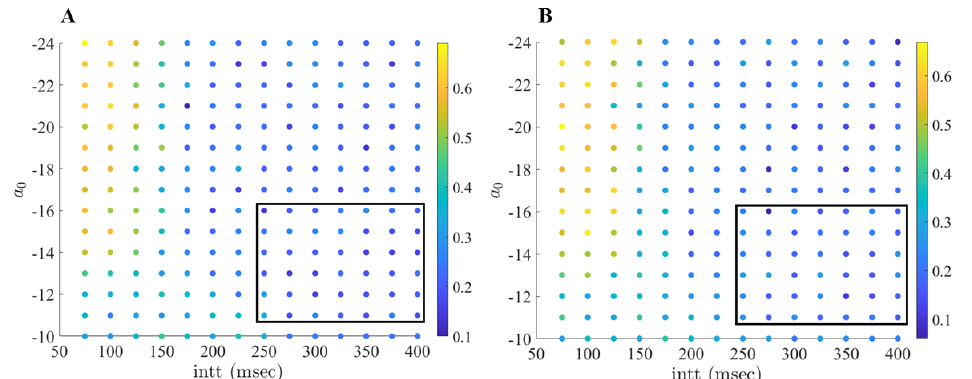
Figure 5. ( A ) Error index values (color coded) for the first TC cell, TC 1 over a range of interspike threshold parameter values intt (75–400 ms, with increment 25 ms) and a 0 —stimulation strength ( − 24 to − 10, with increments of 1). ( B ) Error index values for the second TC cell, TC 2 over a range of values intt (75 to 400 ms, increment 25 ms) and a 0 ( − 24 to − 10, with increment 1). The favorable region of ( intt , a 0 ) pairs is shown in the black box.